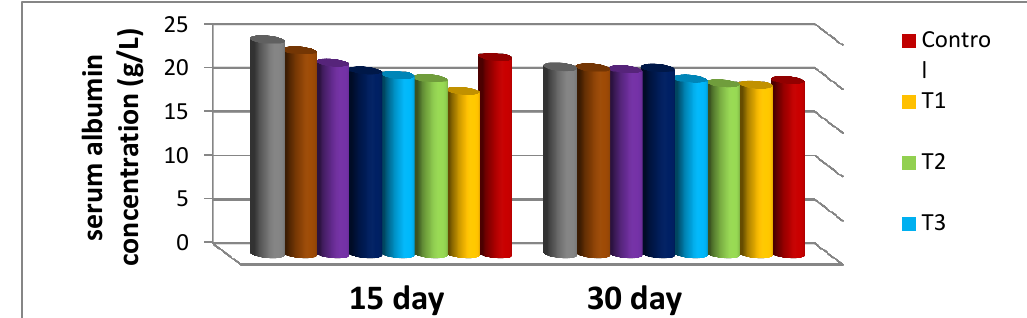
Figure 2: Effect of different doses of total polyphenol extracted from green tea for 15 and 30 days on serum albumin concentration (g/L) of iron overload treated rats.